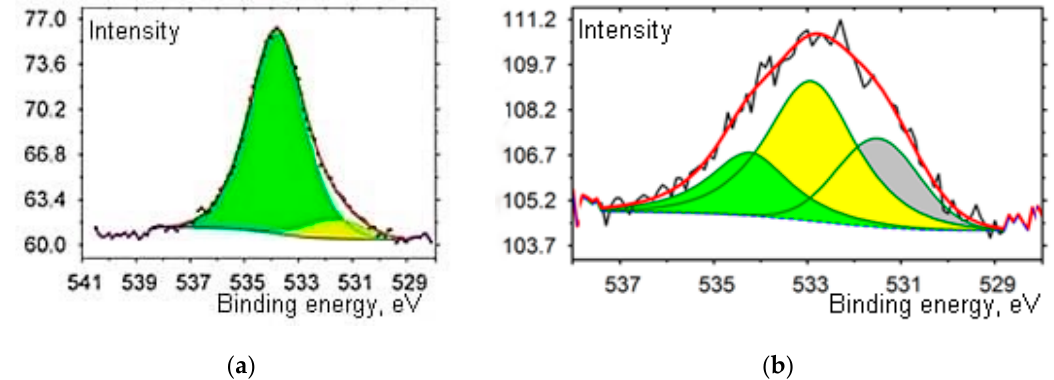
Figure 1. O1s X-ray spectra of carbon nanotubes (CNTs) functionalized with oxygen-containing groups after treatment in NaOH– ( a ) and in HNO 3 – ( b ).